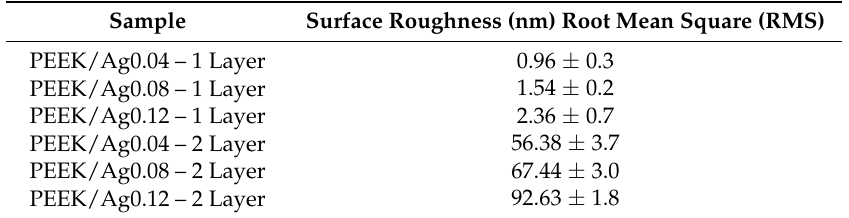
Table 2. Surface roughness values of the different PEEK samples coated with silver.